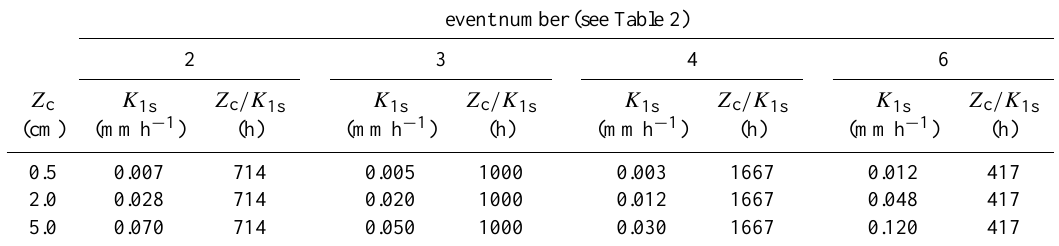
Table 3. Variability of the calibrated saturated hydraulic conductivity, K 1s , and hydraulic resistance ( Z c /K 1s ) for different hypothetical seal thicknesses, Z c . All the events of Table 2 influenced by a sealing layer are